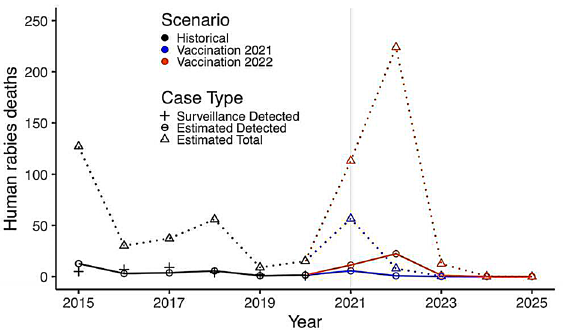
Figure 2. Historical and projected human rabies cases in Haiti, 2015–2025, and potential impact of delaying restarting dog rabies vaccination until either 2021 or 2022. *Black+’s indicate human rabies deaths detected by surveillance from 2015 to 2020. Circles (connected by solid lines) represent model estimates of detected human rabies deaths. Triangles (connected by dotted lines) represent model estimates of total human rabies deaths. We assume 10% of human rabies deaths are detected, which is consistent with estimates from other lower and middle-income countries 13 . Colors compare historical data and estimates for 2015–2020 (black) with model predictions if vaccination campaigns resume in 2021 (blue) or 2022 (orange).